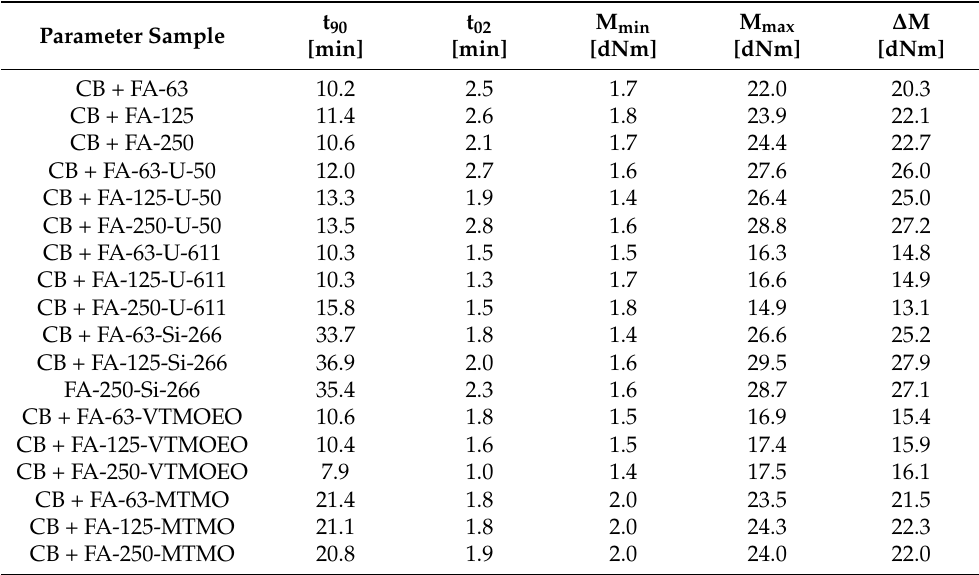
Table 6. Vulcanization parameters of rubber mixtures filled with 30 phr of N-220 and 20 phr of different sizes of FA and treated/untreated by different silanes.